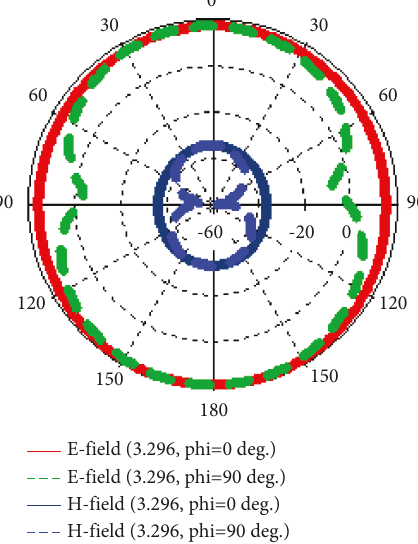
Figure 10: E-field and H-field of the